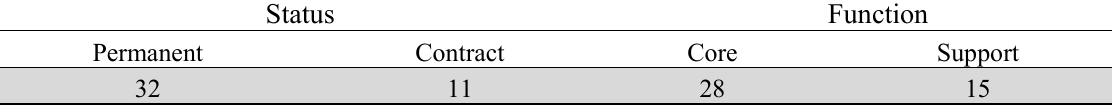
Respondents Data by Employment Status and Job